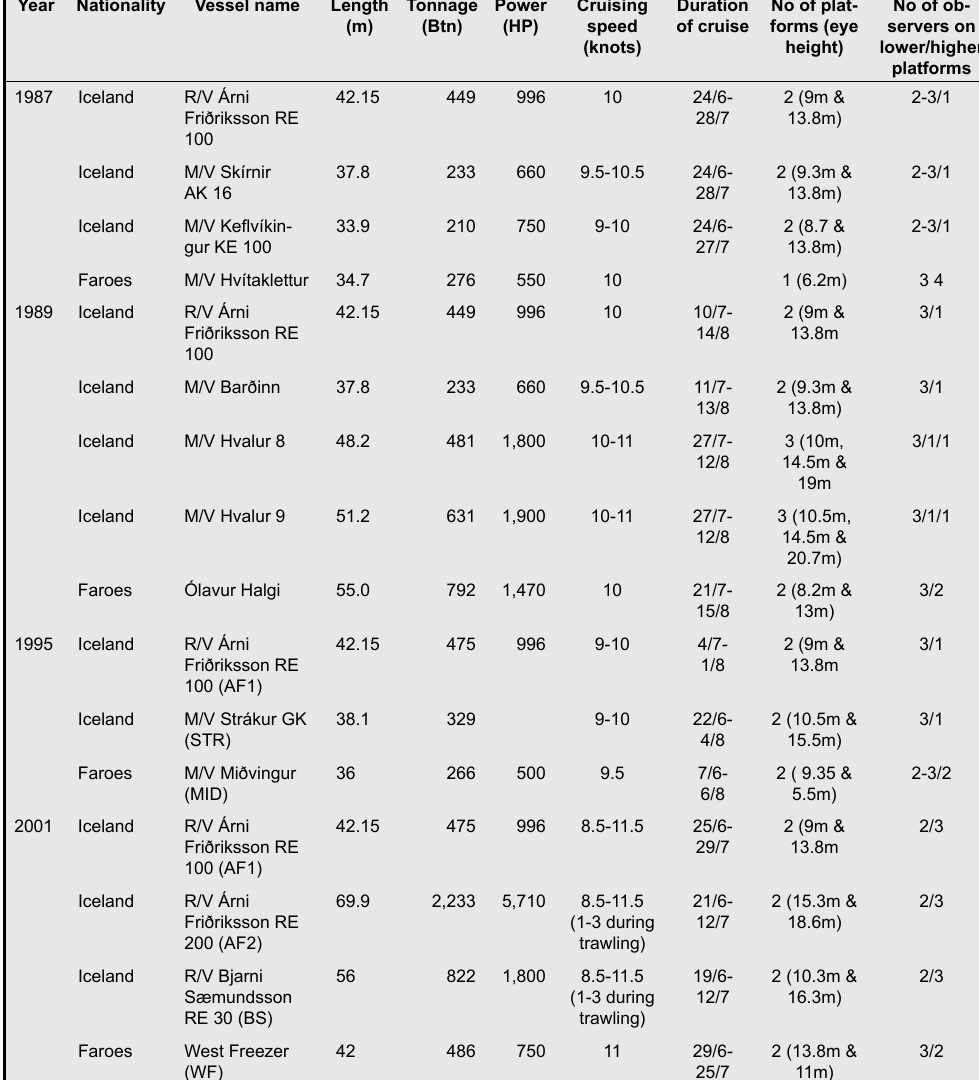
Table 2. Timing and duration of the Icelandic and Faroese NASS cruises 1987-2001, technical details of the participating vessels and number of observers (R/V Árni Friðriksson RE 100 was modified in